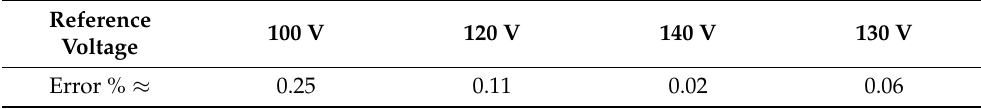
Table 1. Percentage errors for each reference